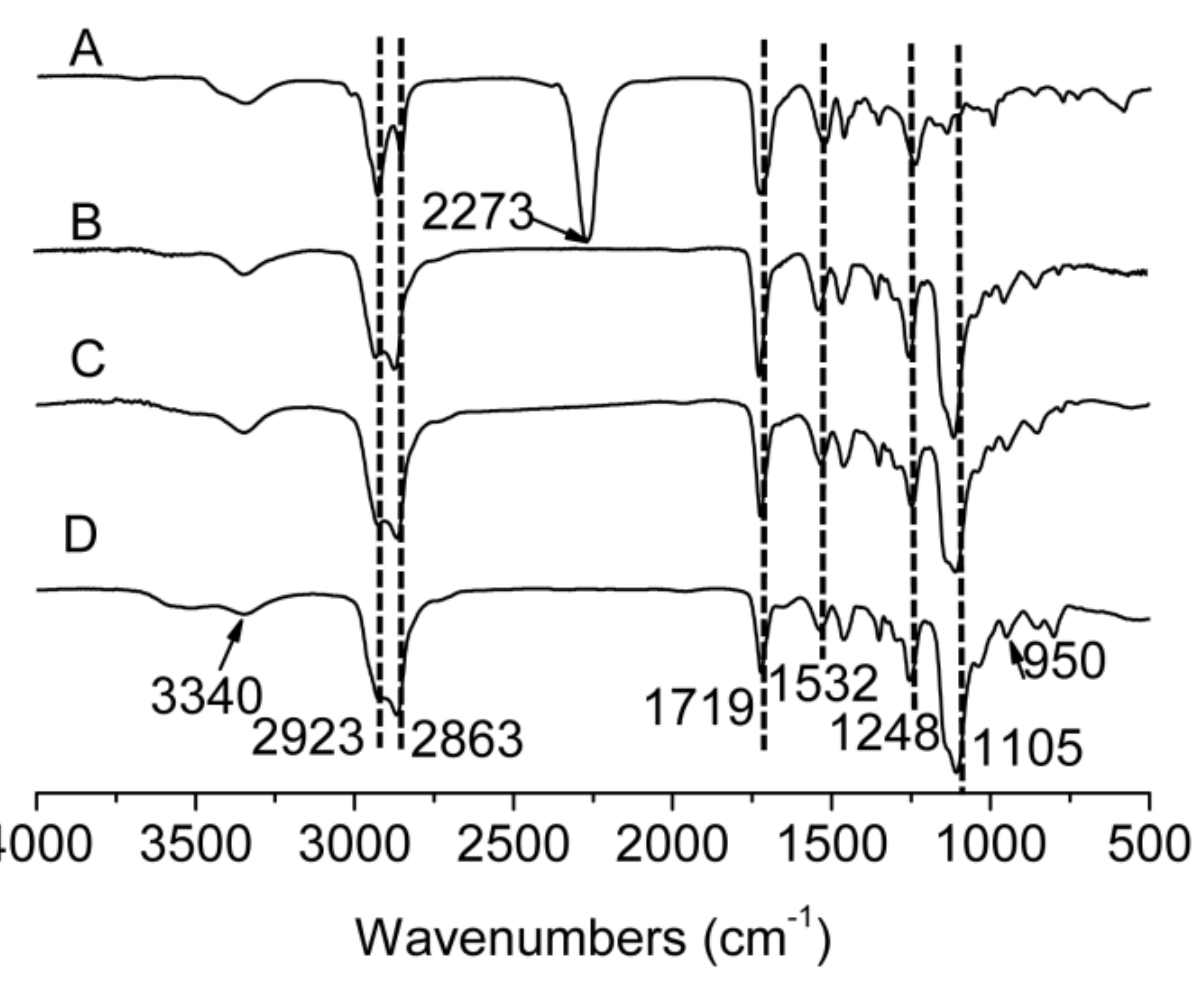
Figure 1. FT-IR spectra of (A) NCO-HTO-NCO, (B) m PEG-HTO- m PEG-1, (C) m PEG-HTO- m PEG-2 and (D) m PEG-HTO- m PEG-3.